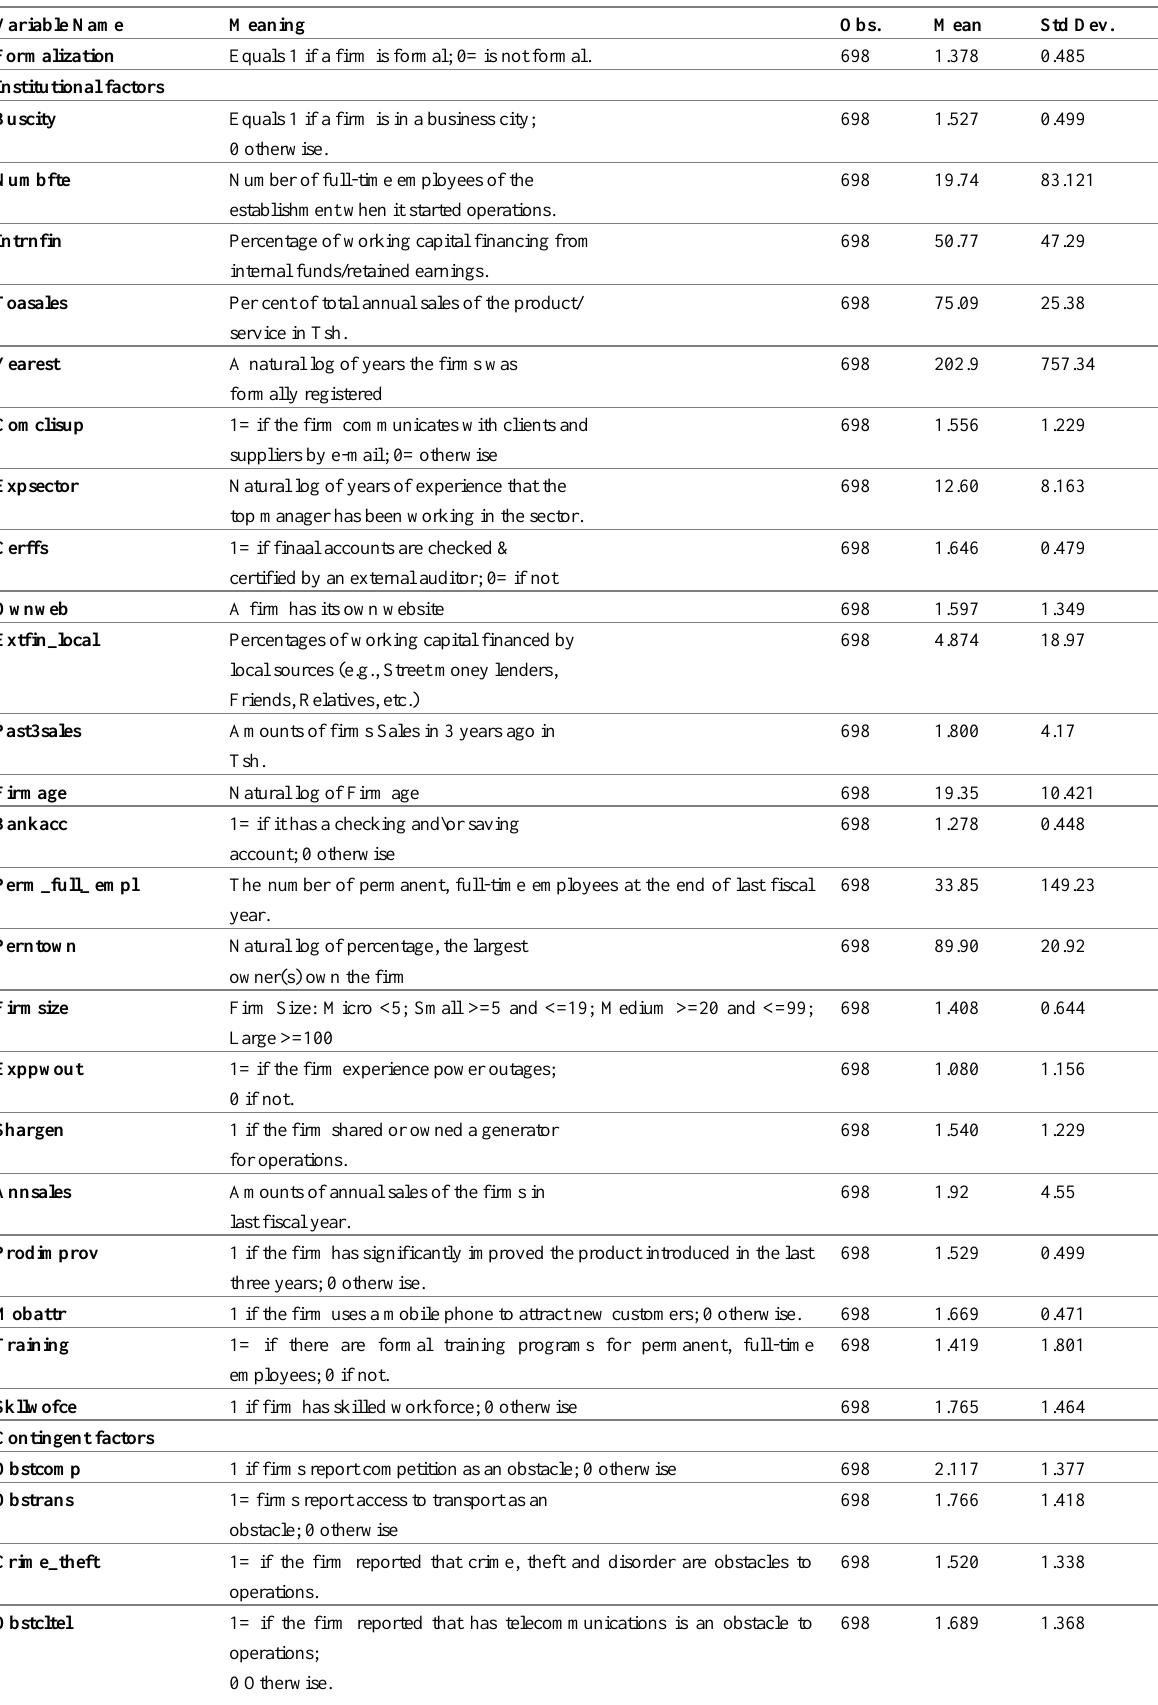
Table 1: Descriptive Summary and Variables